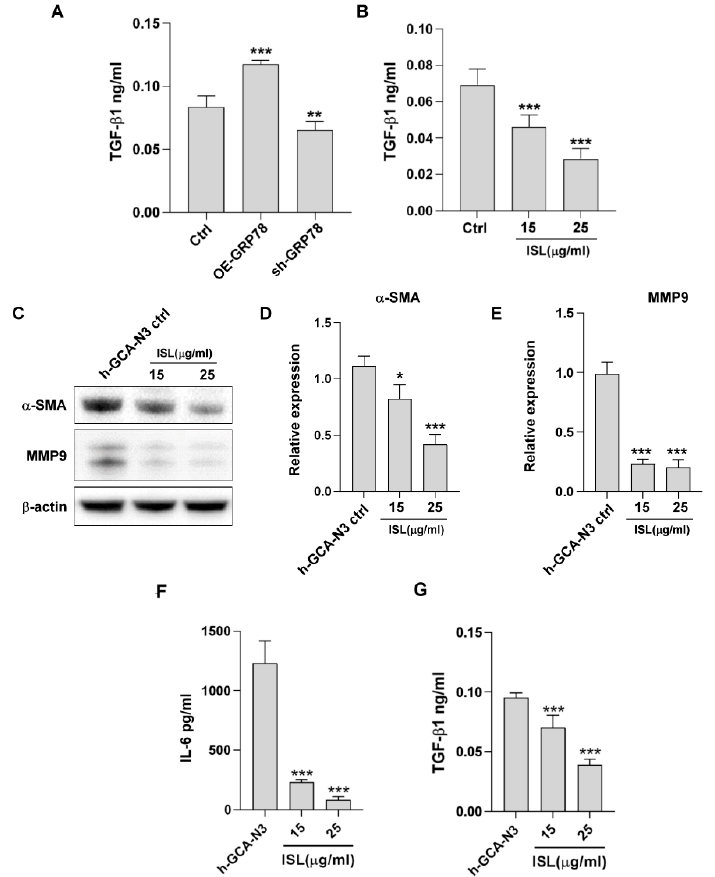
Figure 7. Glucose-regulated protein 78 (GRP78) expression in gastric cancer cells induces cancer- associated fibroblast activity. ( A ) Levels of tumor growth factor (TGF)- β 1 in the condition medium of MKN45/ctrl, MKN45/GRP78+, and MKN45/sh-GRP78 cells. ( B ) Levels of TGF- β 1 in the condition medium in MKN45 cells with or without ISL treatment. ( C ) Protein expression of α -SMA and matrix metalloproteinase (MMP-9) was analyzed through a Western blot after treatment with 15 and 25 μ g/mL isoliquiritigenin (ISL) for 48 h in h-GCA N3 cells. ( D , E ) Quantification of α -SMA and MMP-9 expression was analyzed through a Western blot after treatment with 15 and 25 μ g/mL ISL for 48 h. ( F ) Levels of IL-6 in the conditioned medium in h-GCA N3 cells with or without ISL treatment. ( G ) Levels of TGF- β 1 in the conditioned medium in h-GCA N3 cells with or without ISL treatment. Data are presented as the mean ± standard error of mean; n ≥ 3 independent experiments, two-tailed Student’s t test: * p < 0.05, ** p < 0.01, *** p < 0.005.